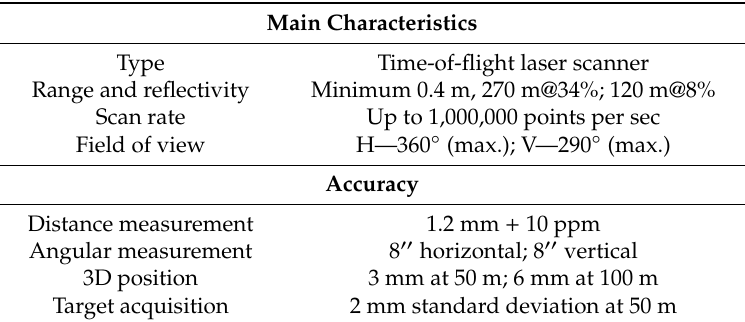
Figure 8. Leica P40 3D terrestrial laser scanner. Table 2. Leica P40 3D scanner characteristics.